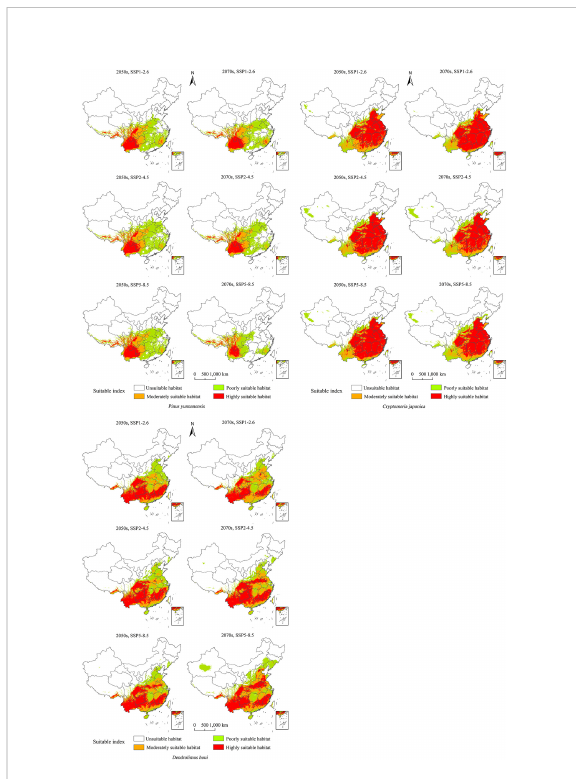
FIGURE 3 Potential habitats suitable for P. yunnanensis , C. fortunei , and D. houi in China.